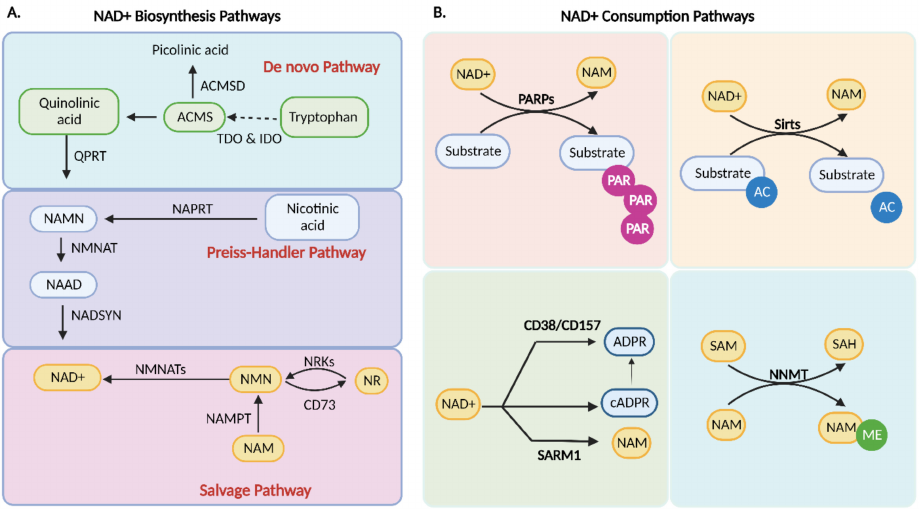
Figure 1. Overview of the NAD + homeostasis. ( A ) The three pathways of NAD + biosynthesis. Mammalian cells synthesize NAD + from tryptophan via the de novo pathway or nicotinic acid via the